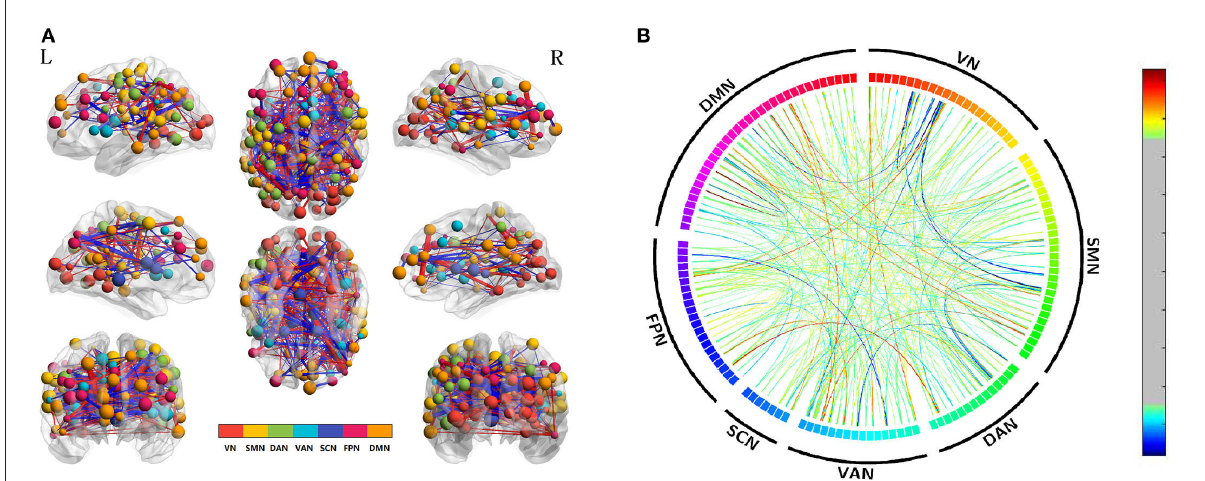
FIGURE3 Altered edge-based functional connectivity for acute SD subjects between after and before acupuncture. (A) The brain maps show the affected edges (lines) and their connecting nodes (spheres) from several perspectives. The size of a node indicates how many affected edges are connected to this sphere. Bigger nodes have more affected edges than smaller ones. The color of a node indicates which network it belongs to. The warm color of edges indicates the increased FC after acupuncture, while the cold color of edges indicates the decreased FC. (B) ROI to ROI connectivity of seven networks in panels. The result was corrected by NBS ( p < 0.01, two-tailed, permutation with 5,000 iterations). DAN, dorsal attention network; DMN, default mode network; FC, functional connectivity; FPN, frontoparietal network; L, left; R, right; SCN, subcortical network; SMN, somatosensory network; VAN, ventral attention network; VN, visual network; SD, sleep